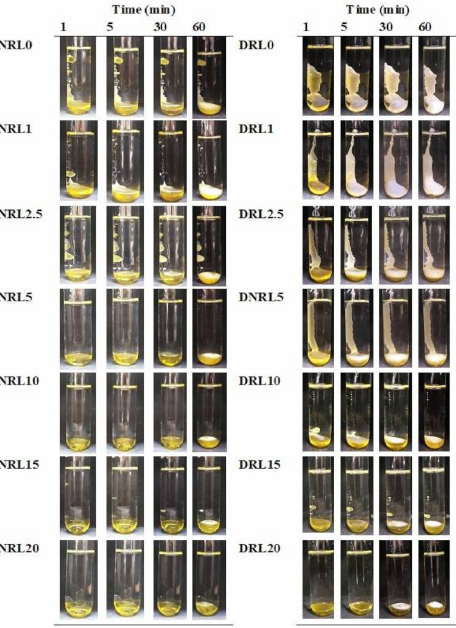
Figure 1. Gel formation of drug-free rosin-based in situ forming gel with various concentrations of LO using NMP and DMSO solvents in PBS pH 7.4 with different time intervals by visual observation. N = NMP, D = DMSO, R = rosin, L = lime peel